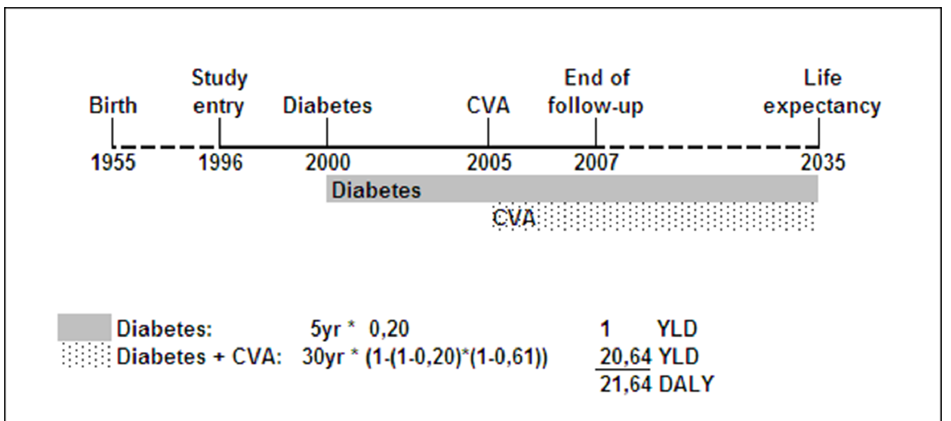
Figure 2. Example of DALY calculation for a participant still alive at truncation of follow-up. Abbreviations: CVA, Cerebrovascular Accident; YLD, Years Lost due to Disability; YLL, Years of Life Lost; DALY, Disability-Adjusted Life Year. The disability weights are as follows; 0.20 for Diabetes, 0.61 for CVA and 1 for death.